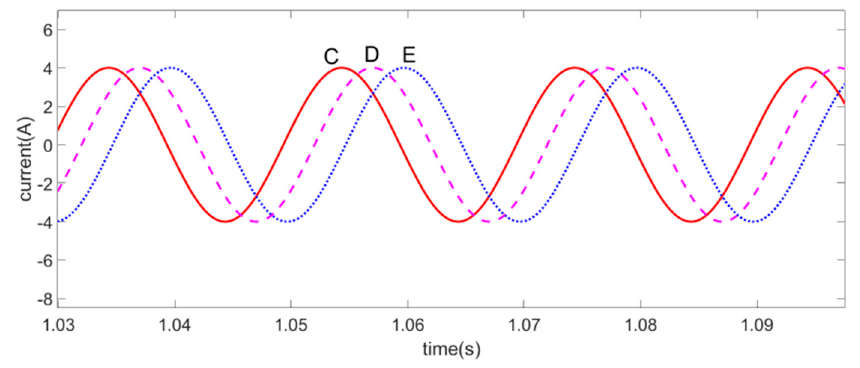
Figure 7. Schematic diagram of remaining three-phase currents after fault-tolerant control in case of open-circuit fault of phase A and B.